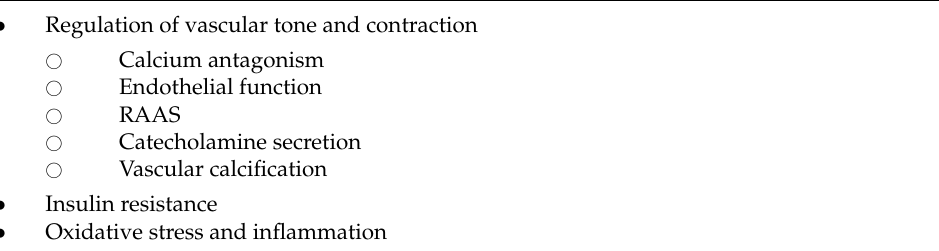
Table 2. Main Mechanisms of Magnesium-related Blood Pressure